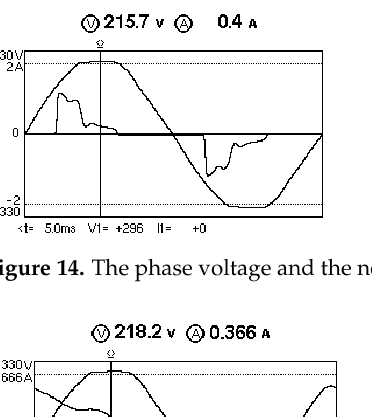
Figure 13. The average value PF and the average value DPF at the three phases depending on the supply voltage at phase a (set 3).